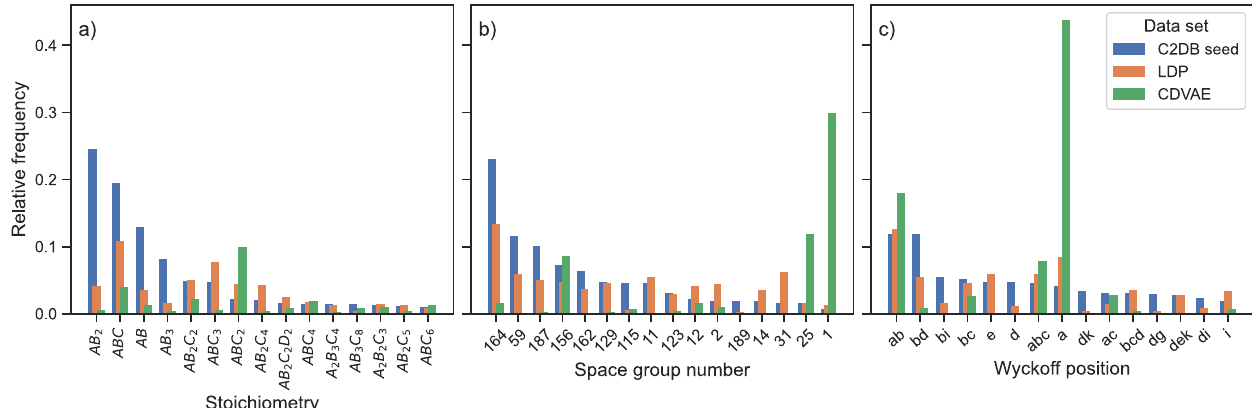
Fig. 6 Histograms of structural parameters. Relative frequency of the stoichiometry, space group number and occupied Wyckoff position for each of the data